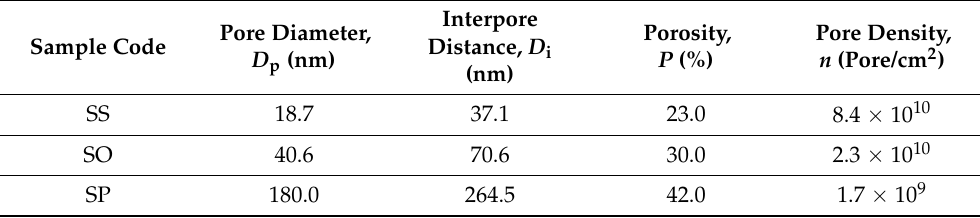
Table 4. Structural parameters for the as-prepared NP-AAO